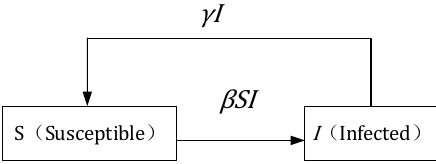
Figure 3. Single channel susceptible-infected-susceptible (SIS) infectious disease model.